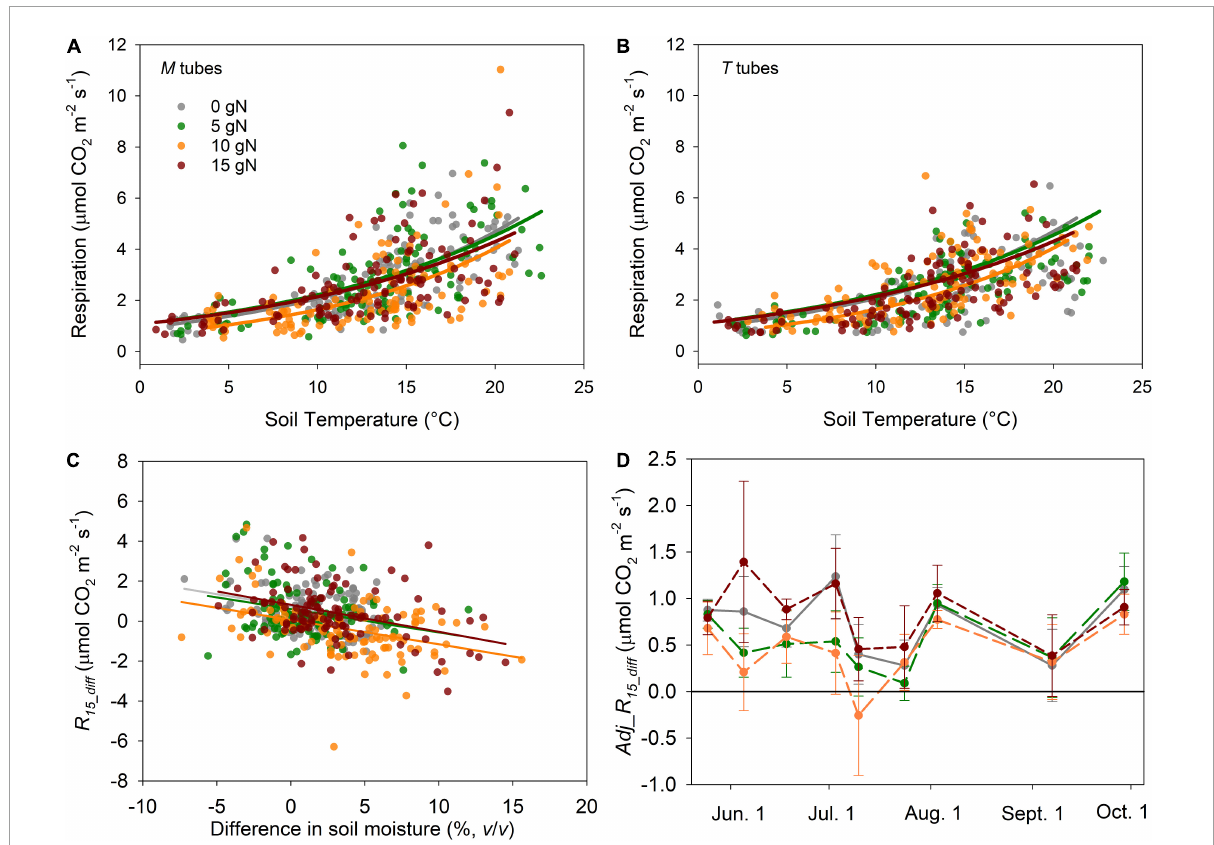
FIGURE5 Raw and adjusted respiration (CO 2 efflux) rates of different fertilization levels in 2011. Exponential relationship between raw respiration rate and soil temperature (5 cm depth) in both M tubes (A) and T tubes (B) . Linear regression of the differences in respiration rate at 15 ◦ C between the paired M tubes and T tubes ( R 15 _diff ) against the corresponding differences in soil moisture (C) . The seasonal dynamics (May to September) of the Adj_R 15 _diff , which was the adjusted difference of respiration between the paired M tubes and T tubes with the same soil temperature (15 ◦ C) and soil moisture (moisture in T tube of each pair) (D) . Both M tubes and T tubes were installed in